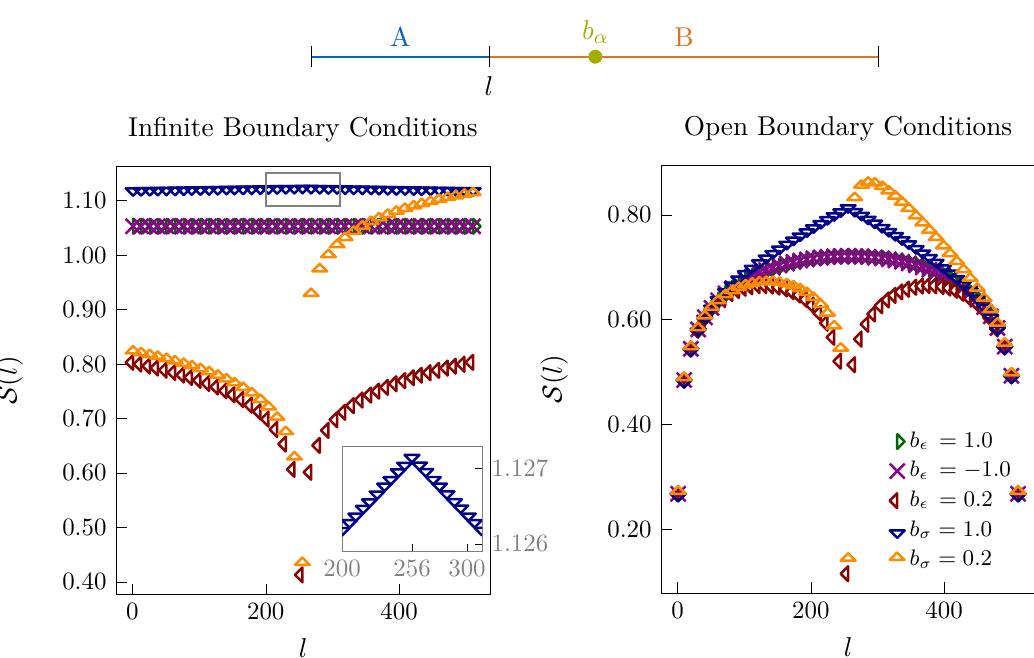
Figure 4 . The EE, S , for different bipartionings of the system for infinite (left) and open (right) bcs obtained by the DMRG calculation for energy and duality defects for χ = 100 . In the middle of the system is an energy (cid:15) -defect or a duality σ -defect of various strength. As for the symmetric EE, the results for the b (cid:15) = ± 1 are identical. For the latter, in the infinite system case, the result is a constant EE for different bipartitionings. The actual value of this constant depends on the amount of entanglement truncation [8, 9] and will be different for different values of χ . The corresponding results for the finite system follow the dependence given in footnote 3. For defect strengths b (cid:15),σ < 1 , the EE exhibits a dip centered at the defect-bond due to the reflections of the entanglement-carrying modes at the defect. On the other hand, the EE is discontinuous for the duality defect with b σ < 1 as the defect is traversed. This is a consequence of the zero energy mode localized at the defect. The situation is different for the topological defect: b σ = 1 , which is associated with a higher interface EE compared to b (cid:15) = 1 (see inset of the left panel for infinite and right panel for finite system results). The scaling of the interface EE with correlation length (system size) for infinite (finite) systems is shown in figure